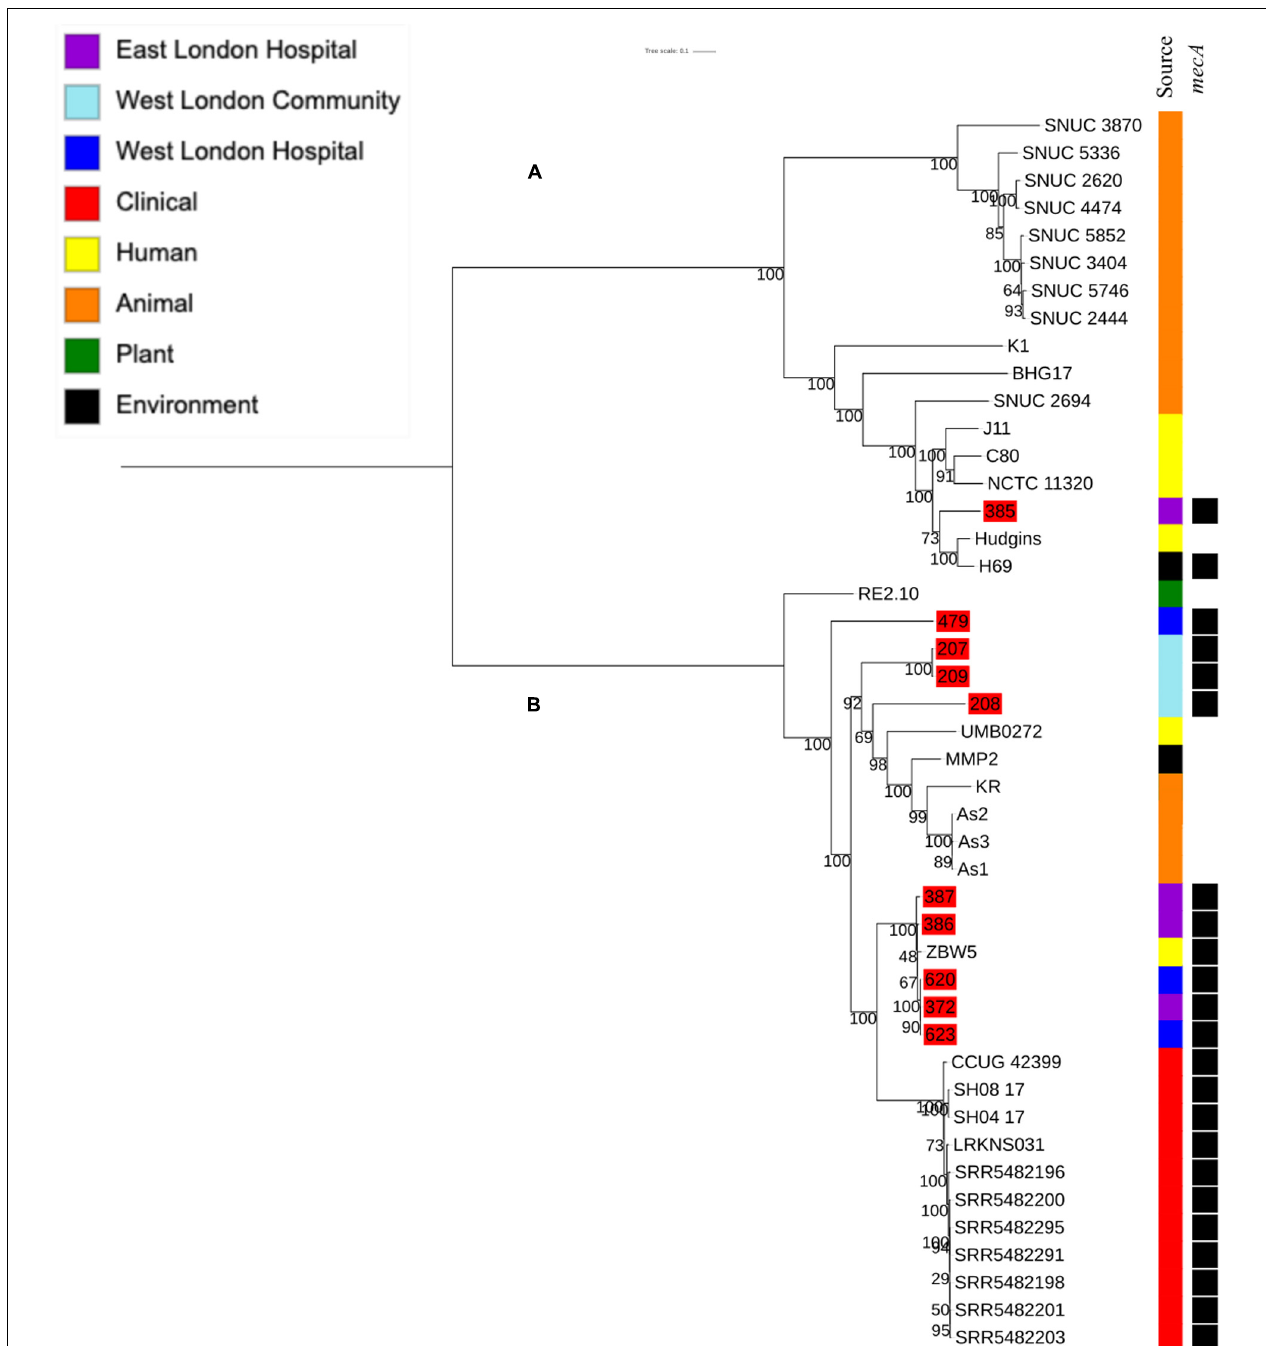
FIGURE 5 | Core SNP maximum likelihood phylogenetic tree of 45 S. hominis , including isolates recovered from public settings in East and West London and those obtained from the ENA. (A,B) represent the two most distinct clades. Isolates recovered from public settings in London are highlighted in